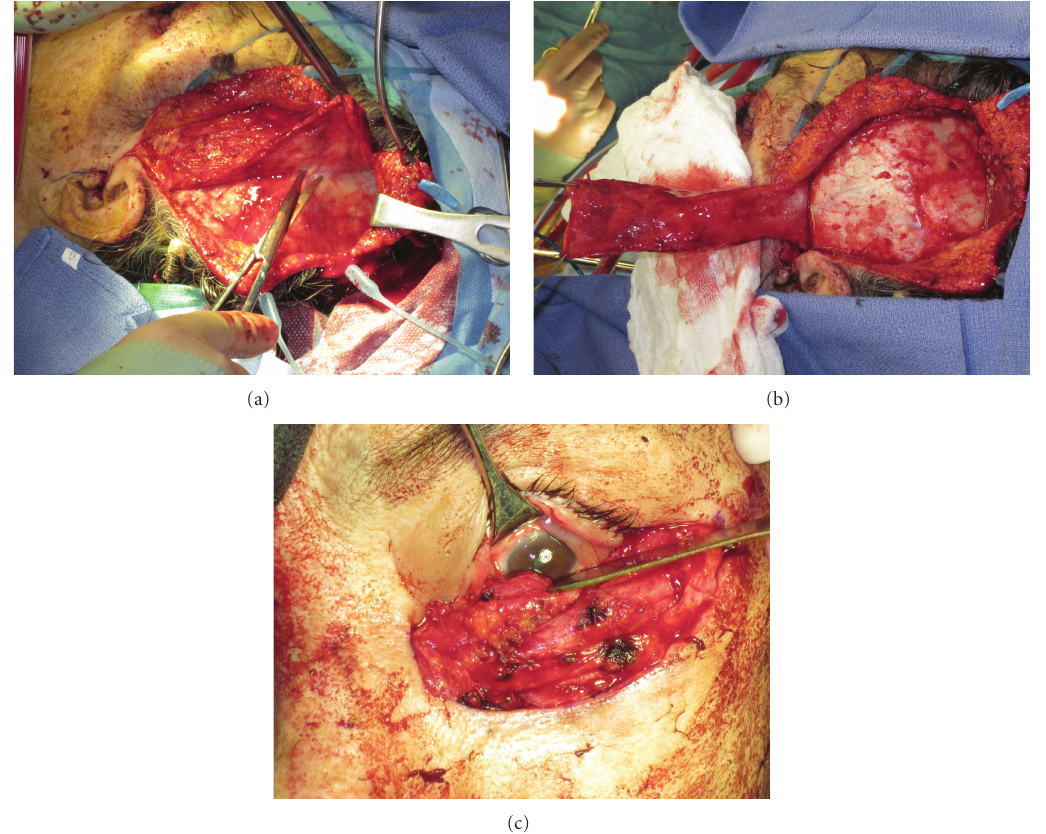
Figure 3: In a lateral quadrant, dissection of the TPF was carried down to the level of the periosteum (a). The fascial flap was then elevated o ff the underlying deep temporal fascia (b). At the level of the orbital rim, the flap was retrieved and pulled across the lower lid defect and sutured into the medial canthus area (c).